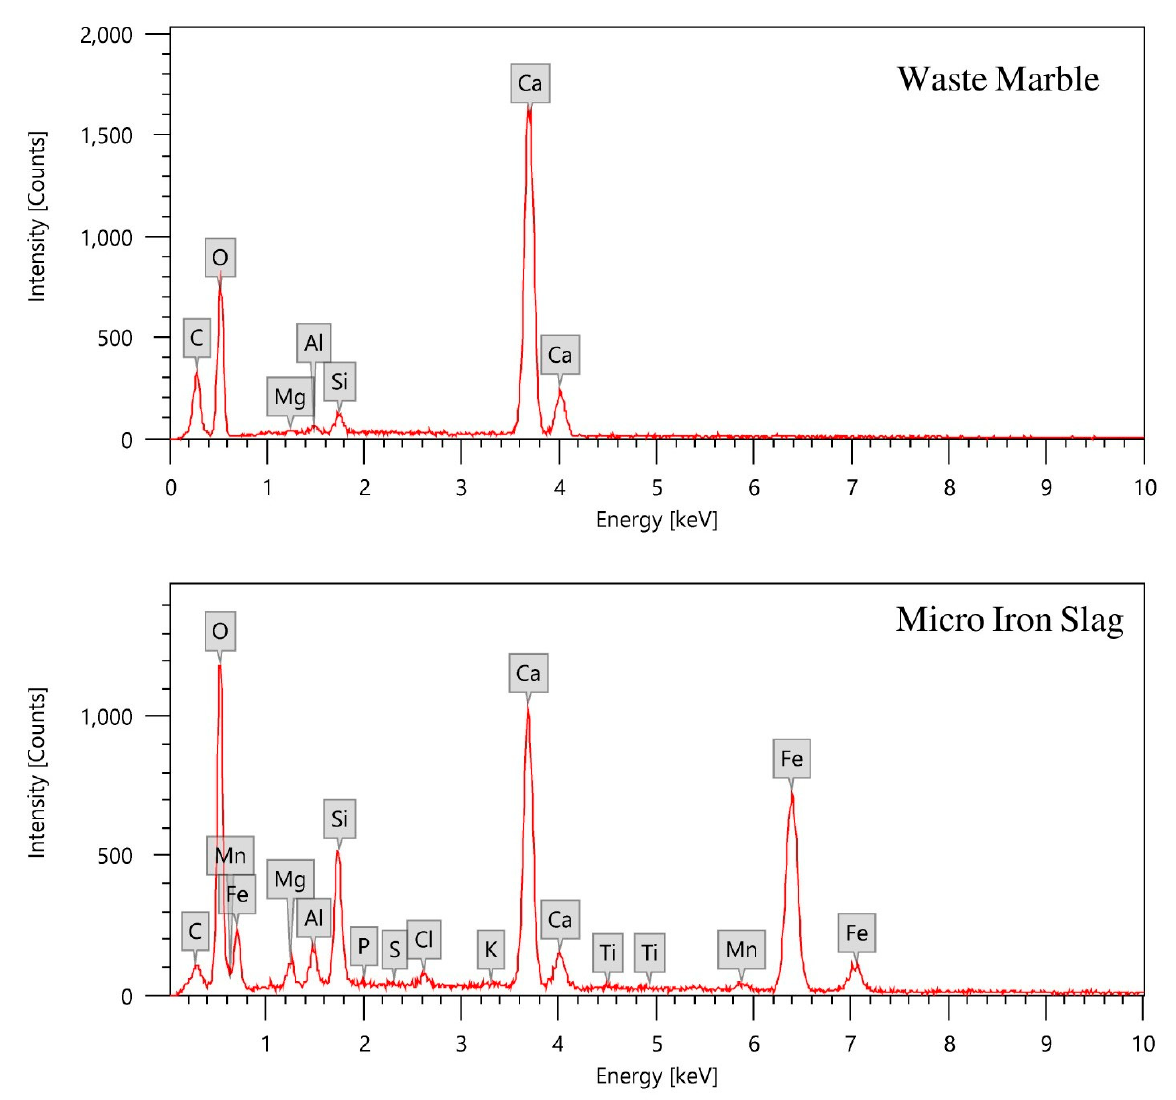
Figure 2. EDX spectra of waste marble and micro iron slag.